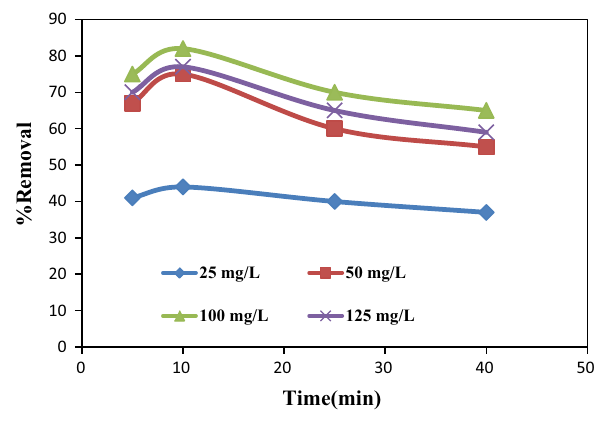
Fig. 3 Effect of Ni(II) ion concentration on nickel adsorption onto MWCNTs. (Optimum MWCNTs dosage 10 mg/L; optimum pH